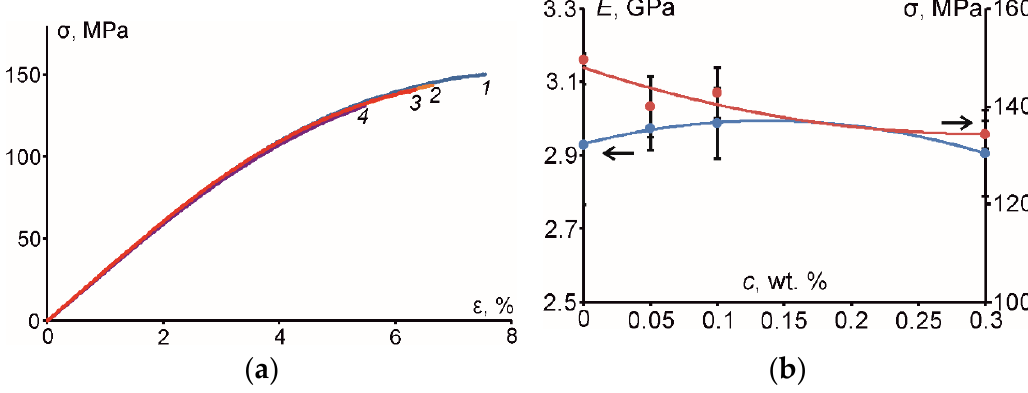
Figure 3. ( a ) Representative stress-strain curves for the epoxy ( 1 ) and epoxy filled with 0.05 wt. % of CNT ( 2 ), 0.1 wt. % of HN ( 3 ), and 0.3 wt. % of CNF ( 4 ); ( b ) elastic modulus and flexural strength of the epoxy and PNC vs. filler weight content (dots—experimental values, lines—polynomial approximations).